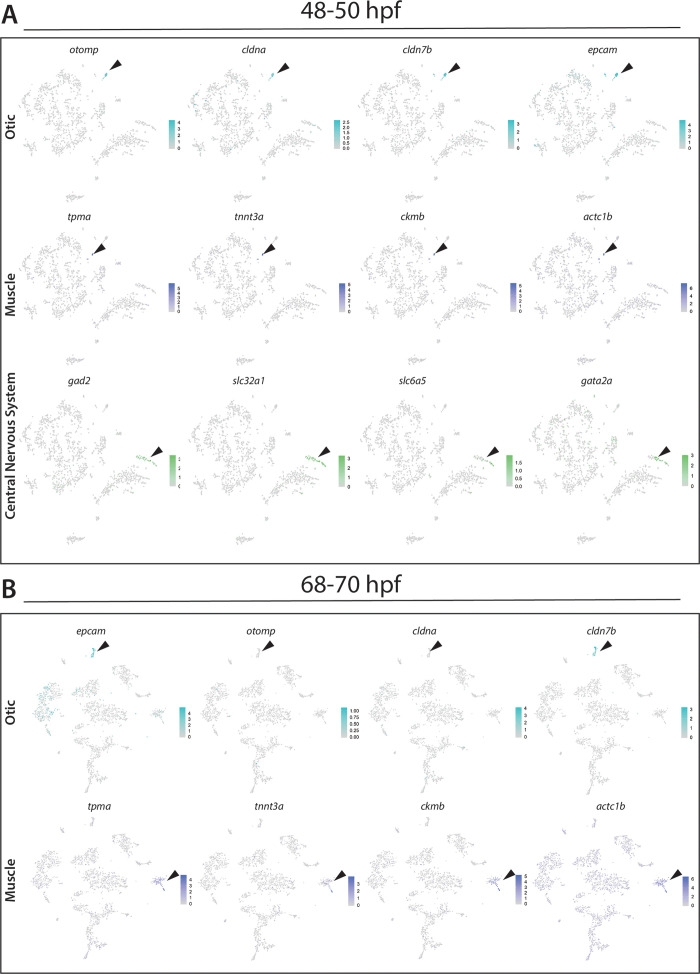
Identification of otic vesicle, muscle, and central nervous system (CNS) cellular populations.(A) Panel of tSNE feature plots at 48–50 hpf that identify combinatorial expression of otic vesicle (otomp, cldna, cldn7b and epcam), muscle (ckmb, actc1b, tnnt3a and tpma), or CNS (slc32a1, gad1b, slc6a5, gata2a) markers. Cluster of interest denoted by black arrows. (B) Panel of tSNE feature plots at 68–70 hpf that identify combinatorial expression of otic vesicle markers (otomp, cldna, cldn7b, and epcam) or muscle (ckmb, actc1b, tnnt3a, and tpma). Cluster of interest denoted by black arrows.